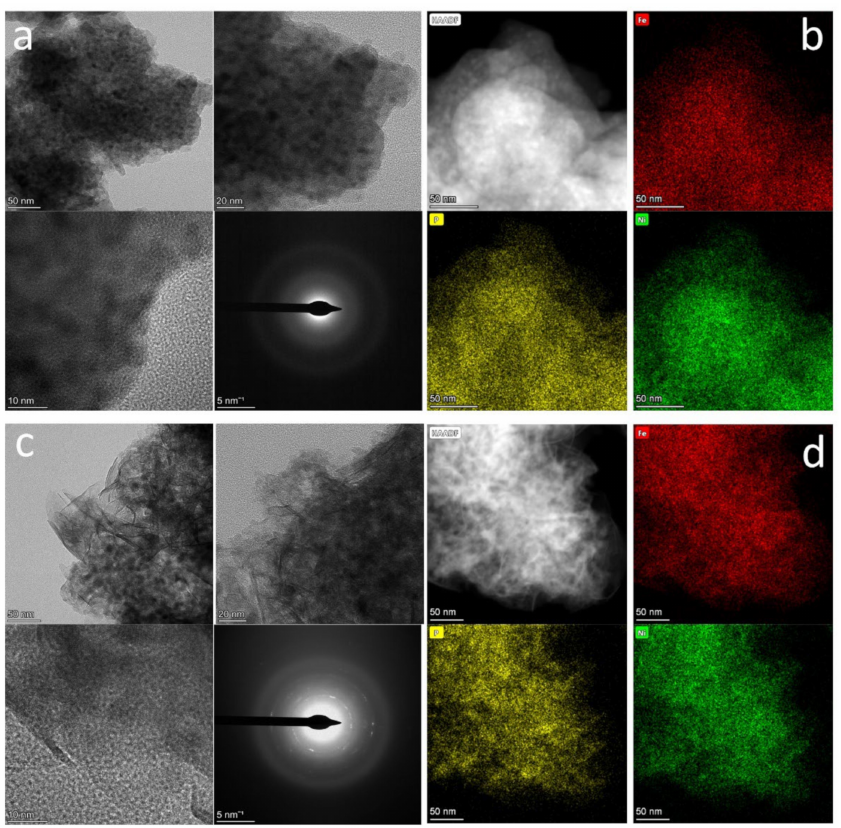
Figure 3. TEM, HRTEM images, and SAED pattern ( a , c ) of N-B-Ni 7 Fe 3 P/SEP and N-B- Ni 7 Fe 3 P/GO; the corresponding EDS maps of Fe, Ni and P ( b , d ) elements of N-B-Ni 7 Fe 3 P/SEP and N-B-Ni 7 Fe 3 P/GO.